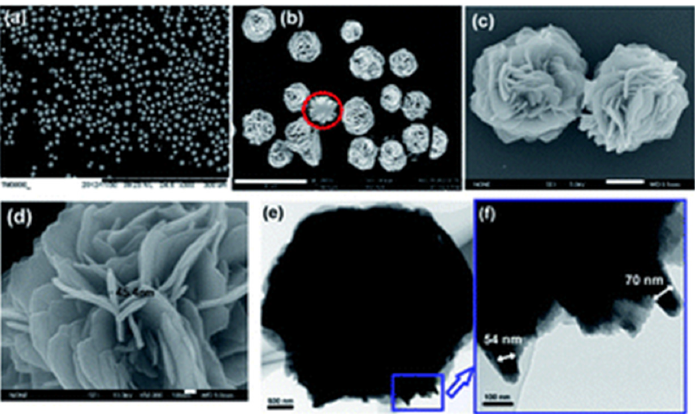
Figure 2. (a ‐ d) Scanning electron microscope (SEM) and (e ‐ f) transmission electron microscope (TEM) images of Ru ‐ metal ‐ organic framework (MOF) nanoflowers at different magnifications, reprinted with